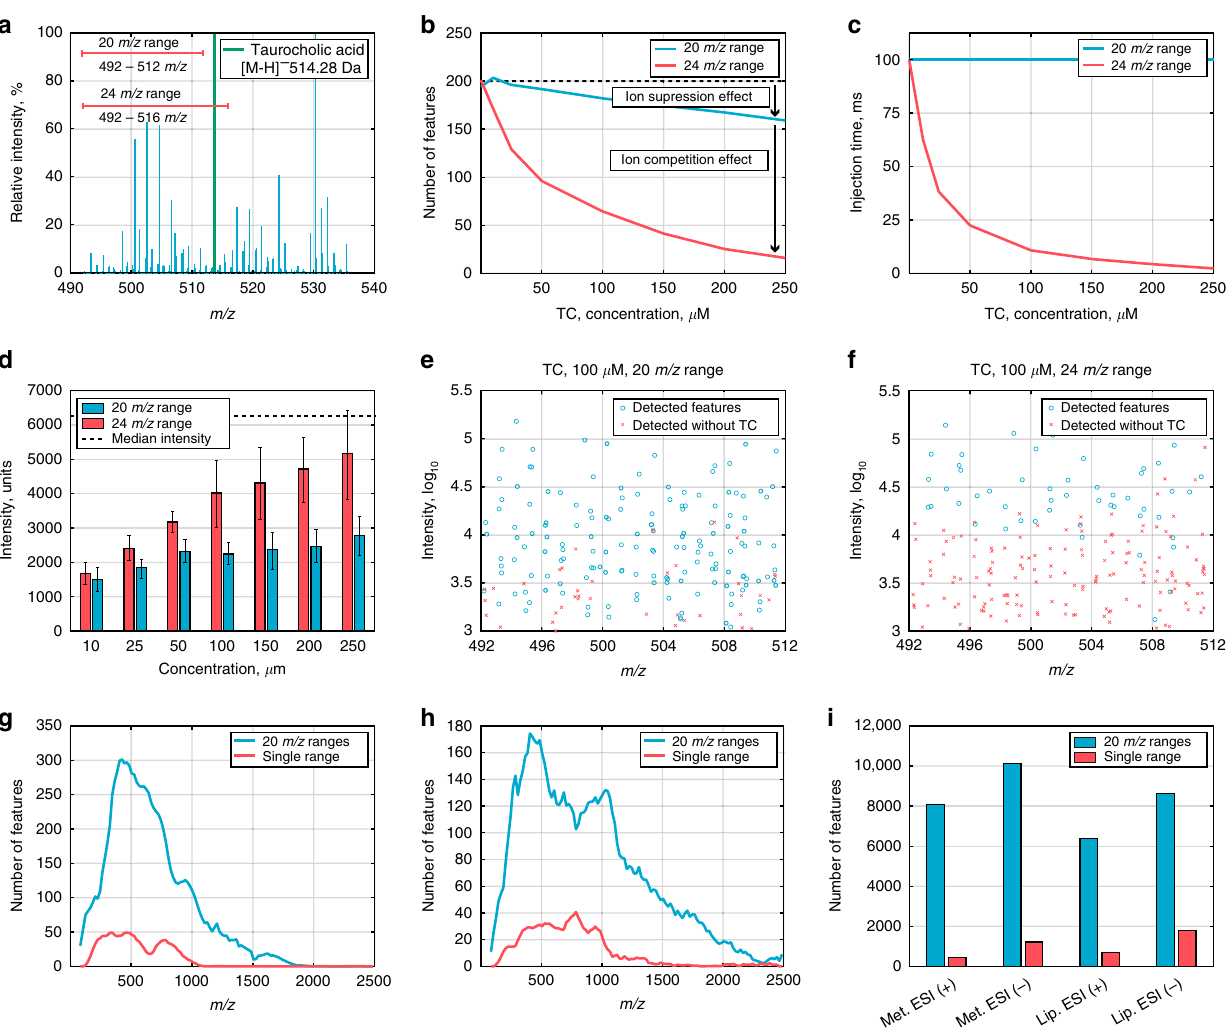
Fig. 1 Ion competition in the detection system explains the reduced sensitivity of FI-MS. a An experimental scheme for investigating ion suppression and ion competition effects in FI-MS analysis: gradually increasing the ion fl ow by adding increasing concentrations of some compound to the analyte, while con fi guring the mass spectrometer to scan for two overlapping ranges that include or exclude the added compound; here, taurocholic acid (TC) was added to metabolite extracts from serum samples, while a 20 m/z scan range, which excludes this compound and an overlapping 24 m/z scan range that includes it are scanned. b The number of reproducible m/z features found (within the narrower scan range) when scanning for the 20 m/z scan range (in blue) and for the 24 m/z scan range (in red), adding increasing concentrations of TC; black horizontal line represents the number of m/z features detected without adding TC. c Observed injection time of curved linear trap as a function of the concentration of the added TC. d The median intensity of m/z features ( n ≥ 15; ±SEM; measured without adding TC; y axis) which become undetected when adding increasing concentrations of TC ( x axis), scanning for the 20 m/z scan range (in blue) and for the 24 m/z scan range (in red); black horizontal line represents the median intensity of m/z features detected without adding TC. Ion intensity ( y axis) and m/z ( x axis) detected in serum when scanning for the 20 m/z scan range ( e ) and the 24 m/z scan range ( f ); ions undetected when adding 100 μ M of TC are marked with red crosses. Distributions of the number of reproducible m/z features found by spectral-stitching FI-MS method (20 m/z scan ranges; in blue) versus scanning using a single range (in red) for metabolomics ( g ) and lipidomics ( h ) analysis (negative ionization mode). i The total number of reproducible m/z features found by spectral-stitching FI-MS (in blue) versus scanning using a single scan range (in red), for metabolomics and lipidomics, in positive and negative ionization modes. Source data are provided as a Source data fi